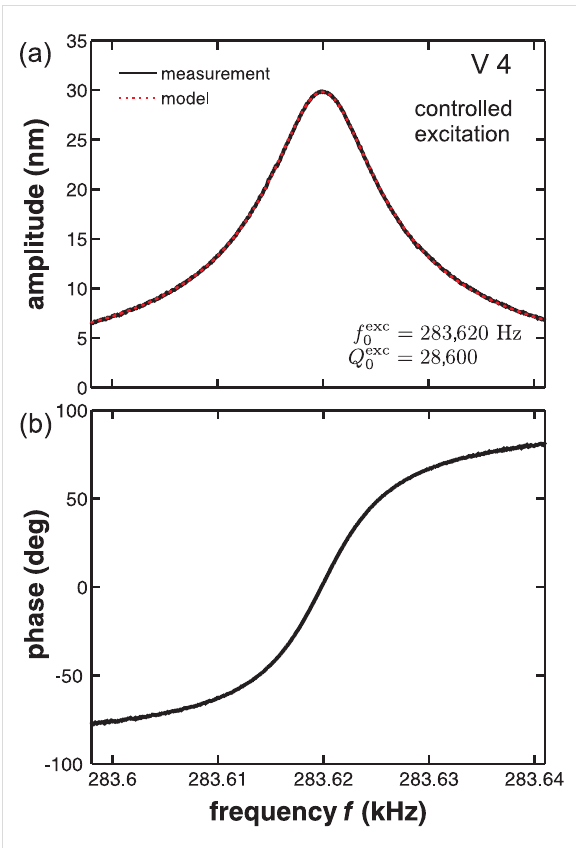
Figure 2: (a) Measured resonance curve (solid line) of the excited cantilever V 4 with a fit (dotted line) of Equation 3 from [12] to experi- mental data yielding and . (b) Phase response of the excited cantilever V